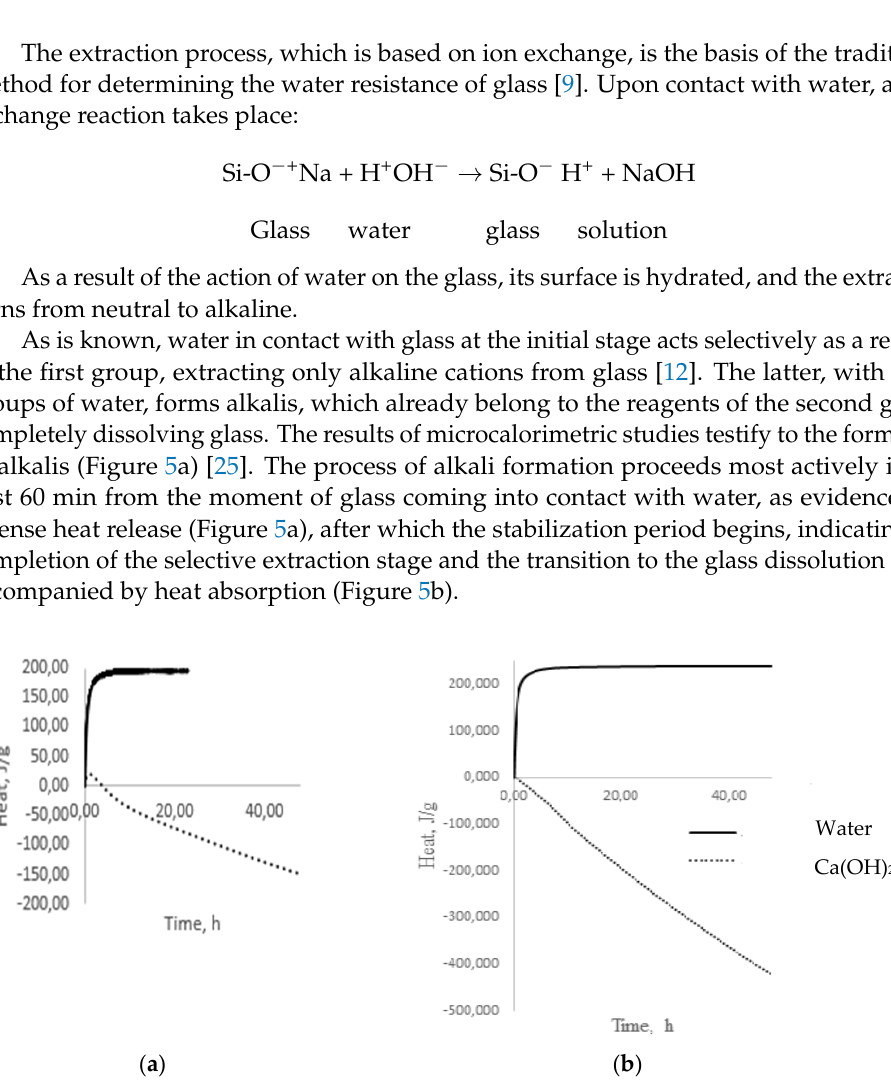
Figure 5. Dependence of heat release on time when glass comes into contact with water and Ca(OH) 2 : ( a ) green glass; ( b ) low ‐ alkali borosilicate glass.